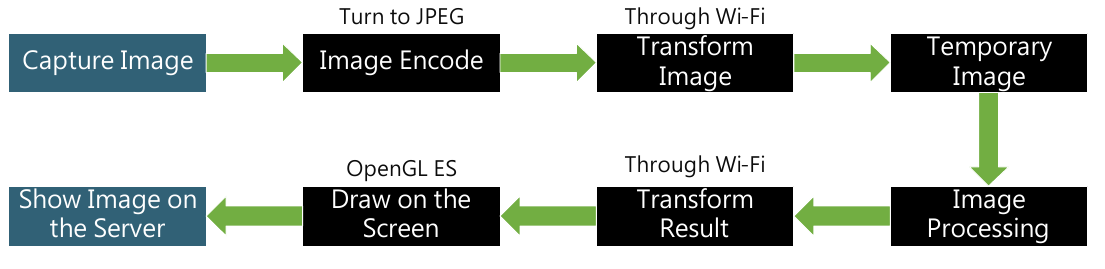
Figure 47. Flowchart of the system.